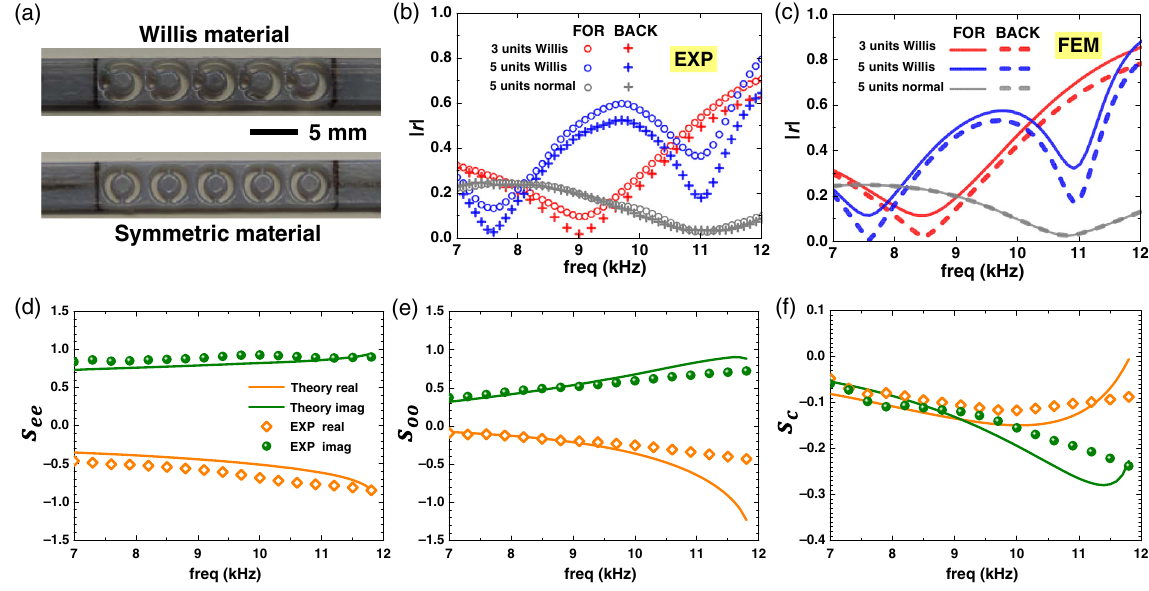
FIG. 2. Experimental testing of asymmetric reflection and extraction of Willis coupling. (a) Photograph of Willis and symmetric metamaterials. (b),(c) The experimentally tested and simulated reflected amplitude of different cases, respectively. For the symmetric material, r 1 ¼ 0 . 4 a 0 , d ¼ 0 . 4 mm, orientation angles of the two thin ribs being set along the y direction. Other geometric and material parameters are same as the Willis case. (d) – (f) The theoretical (solid lines) and experimental (symbols) values of the even scattering coefficient s , the odd scattering coefficient s , and the cross-coupling scattering coefficient s of the Willis ee oo c